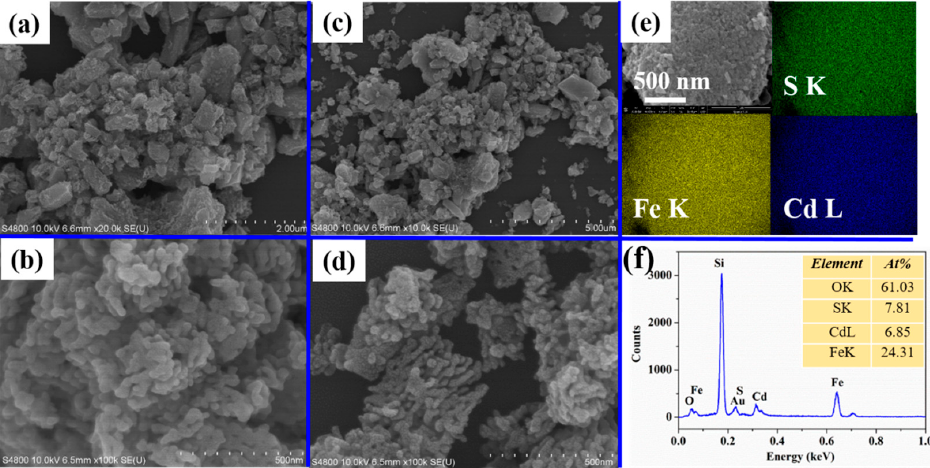
Figure 2. SEM images of ( a , b ) F450 and ( c , d ) 5-CdS / F450; ( e ) mapping images of 5-CdS / F450; ( f ) EDS spectrum of 5-CdS / F450, the inset is the corresponding semiquantitative analysis. Table 1. ICP data of samples.